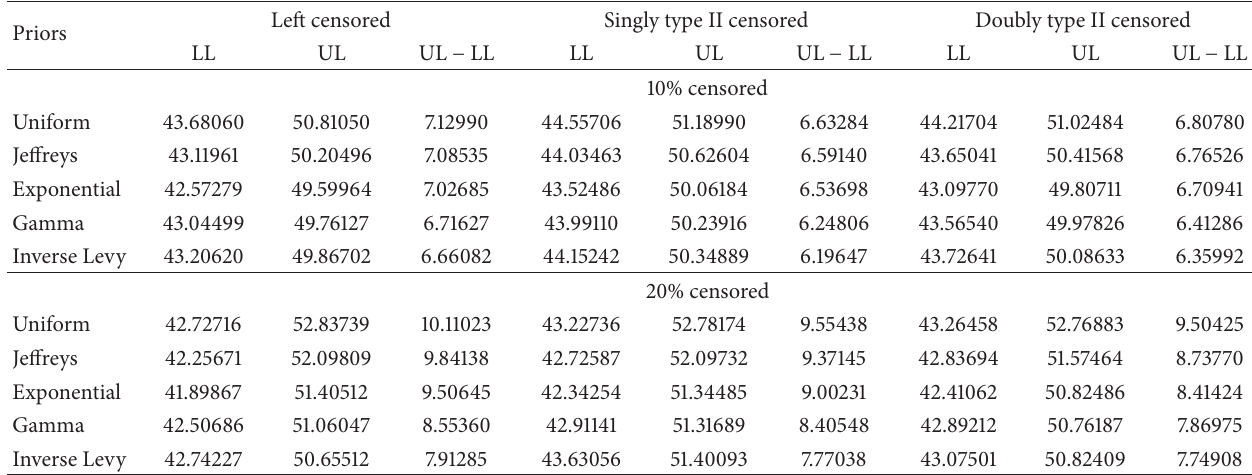
Table 9: 95% credible intervals under real life